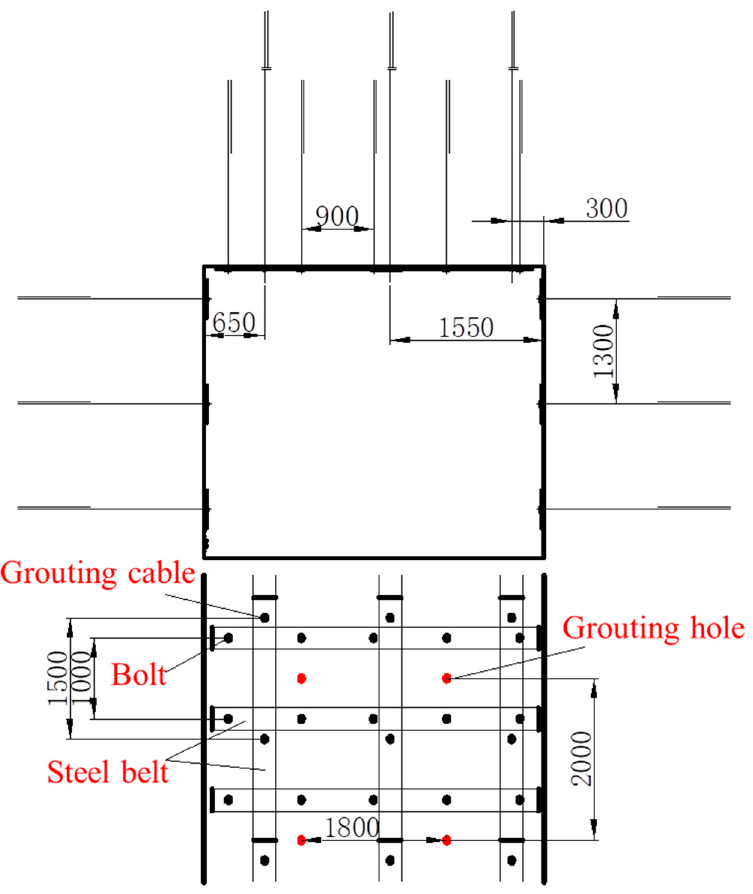
Figure 10. Roadway support scheme.